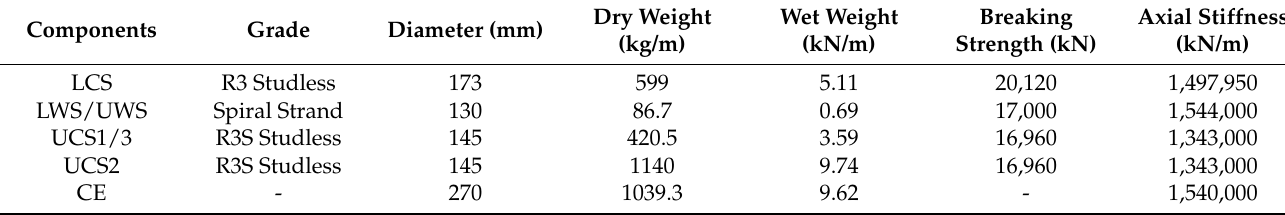
Table 3. Properties of mooring line